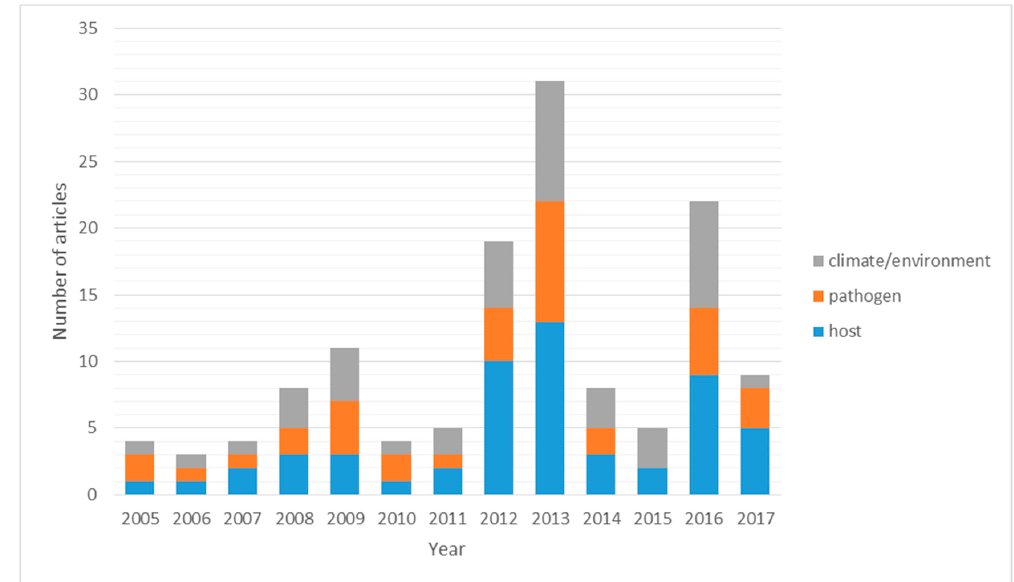
Figure 1. Number of articles retrieved on SCOPUS (https://www.scopus.com/) using the search terms “forest pathogen”, “invasive” and “variability” (as of 27 July 2017) partitioned according to the three main elements of the plant disease triangle.